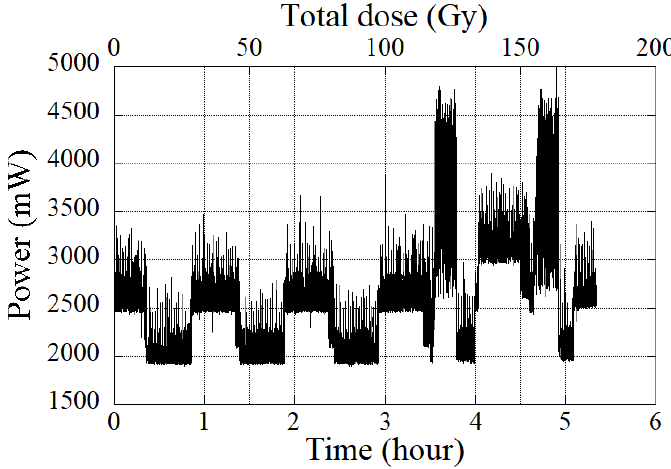
Figure 8. Power consumption of Raspberry Pi Compute Module 3+ during radiation test.